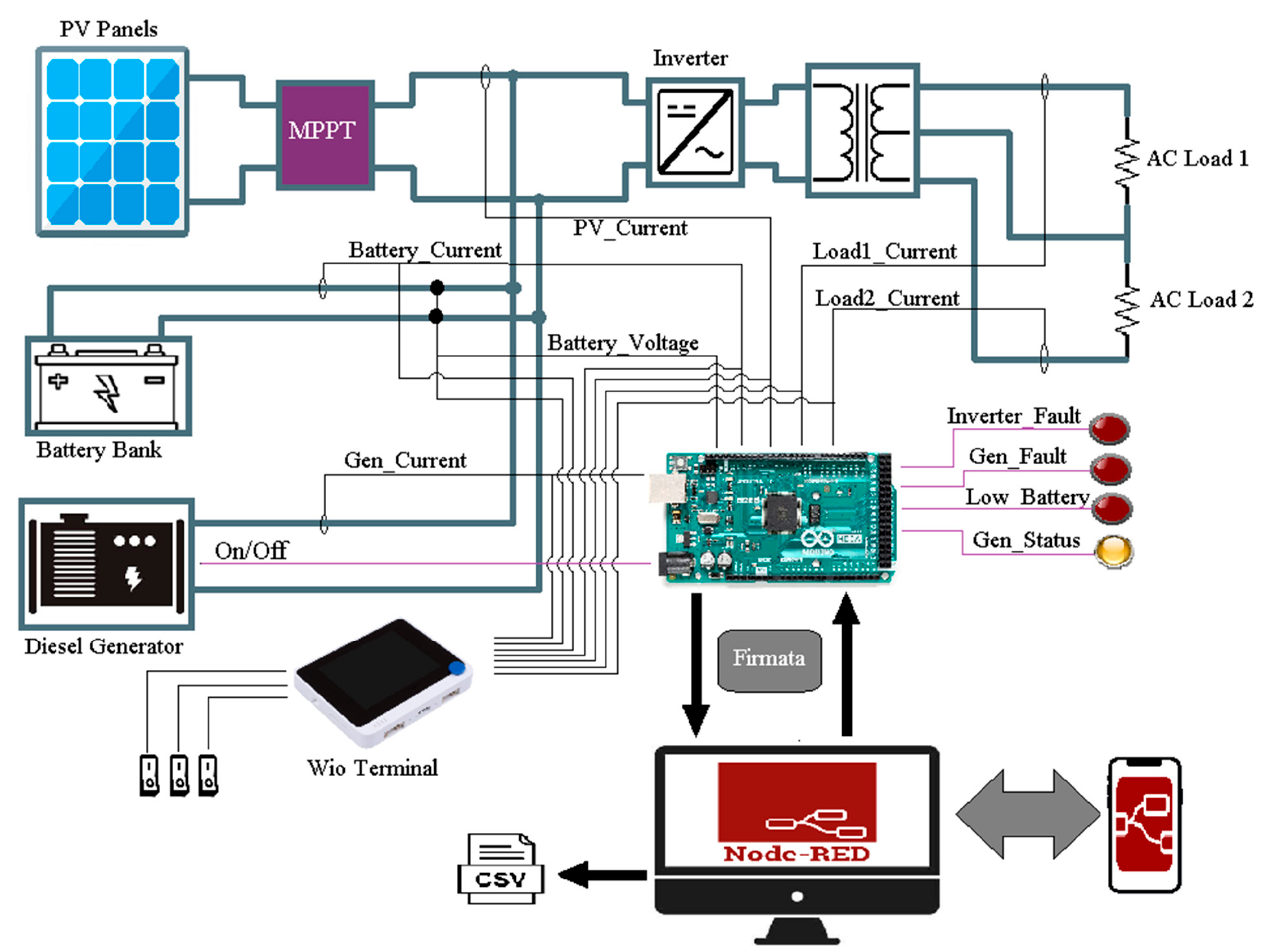
Figure 1. Designed SCADA system for a hybrid renewable power system.